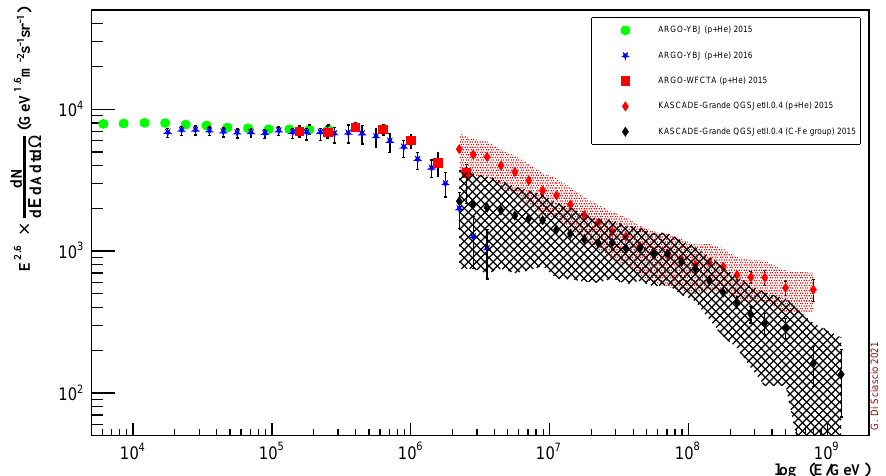
Figure 9. The energy spectra of the light component measured by ARGO–YBJ compared to the light and heavy components measured by